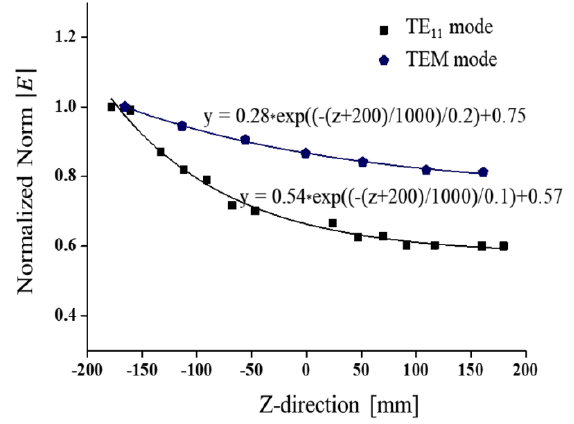
Figure 11. Attenuation of electric field norm |𝐸| along